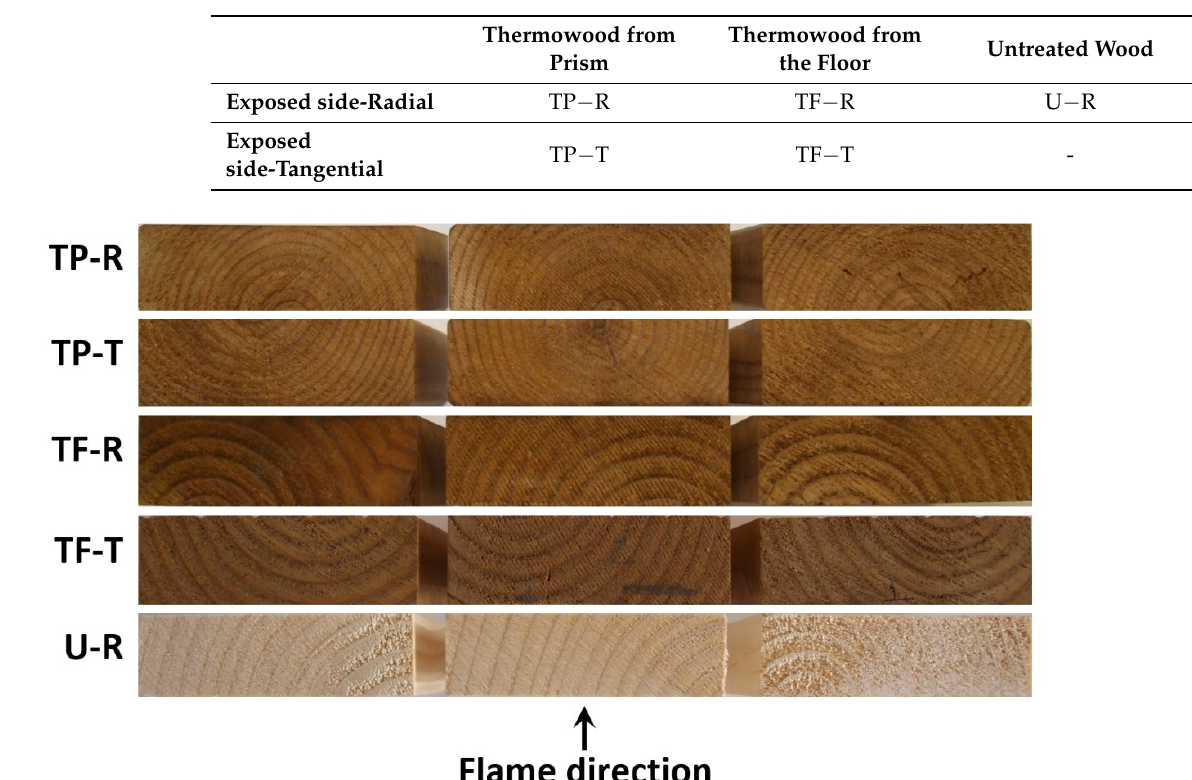
Table 1. Designation of individual specimen groups.